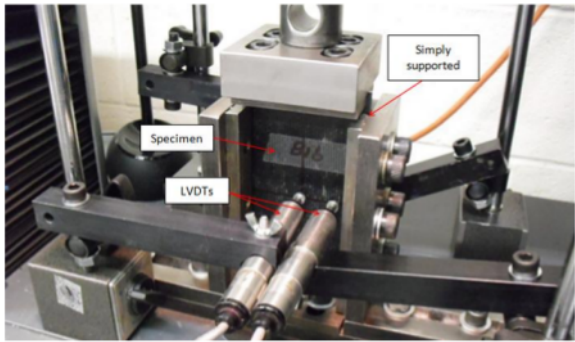
Figure 3: Clamped-simply supported-clamped-simply supported (CSCS) buckling testing rig during operation.